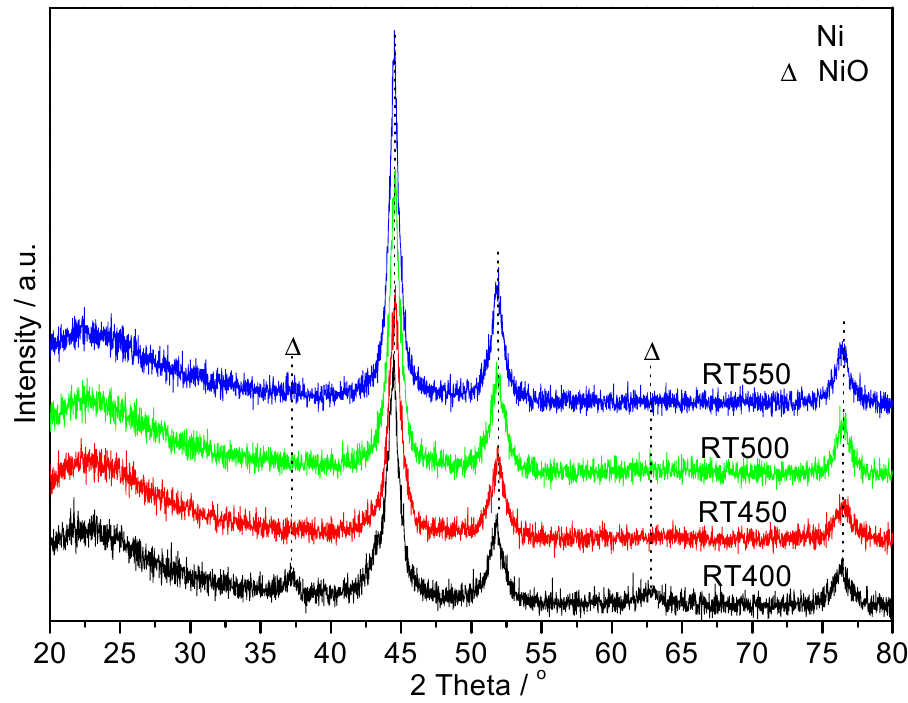
Figure 2. XRD patterns of RTx catalysts. (x = 400, 450, 500, and 550).